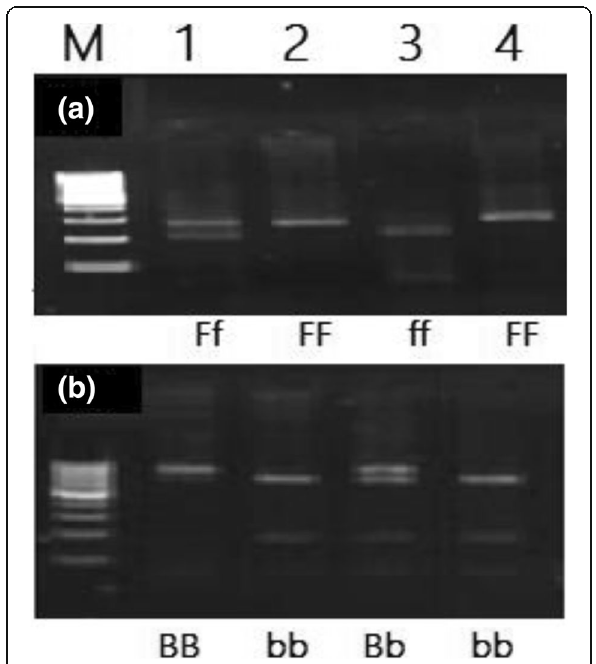
Fig. 1 Detection of the VDR SNPs through electrophoresis patterns of PCR amplification products. a 4% agarose gel stained with ethidium bromide and UV transillumination electrophoresis pattern for VDR FokI where: M: molecular weight marker (100 bp each); Lane 1: heterozygote (Ff) genotype with three bands at 265, 196, 69 bp; Lanes 2, 4: homozygote (FF) genotype with only one band at 265 bp; Lane 3: homozygote (ff) genotype with two bands at 196 and 69 bp. b 4% agarose gel stained with ethidium bromide and UV transillumination electrophoresis pattern for VDR BsmI where: M: molecular weight marker (100 bp each); Lane 1: homozygote (BB) genotype with only one band at 850 bp; Lanes 2, 4: homozygote (bb) genotype with two bands at 650 and 200 bp; Lane 3: heterozygote (Bb) genotype with three bands at 850, 650,